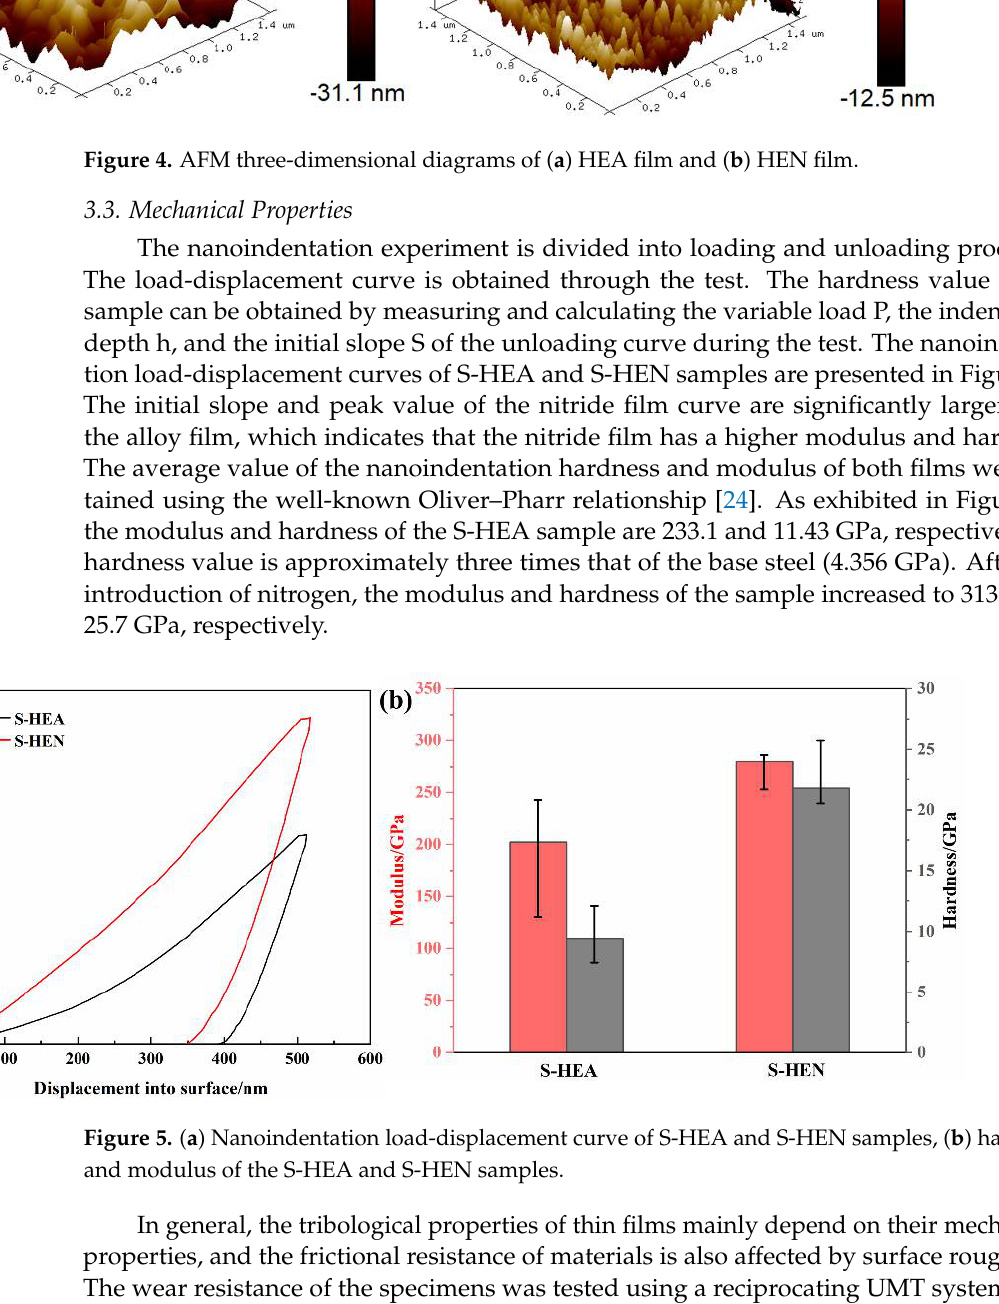
Figure 5. ( a ) Nanoindentation load-displacement curve of S-HEA and S-HEN samples, ( b ) hardness and modulus of the S-HEA and S-HEN samples.